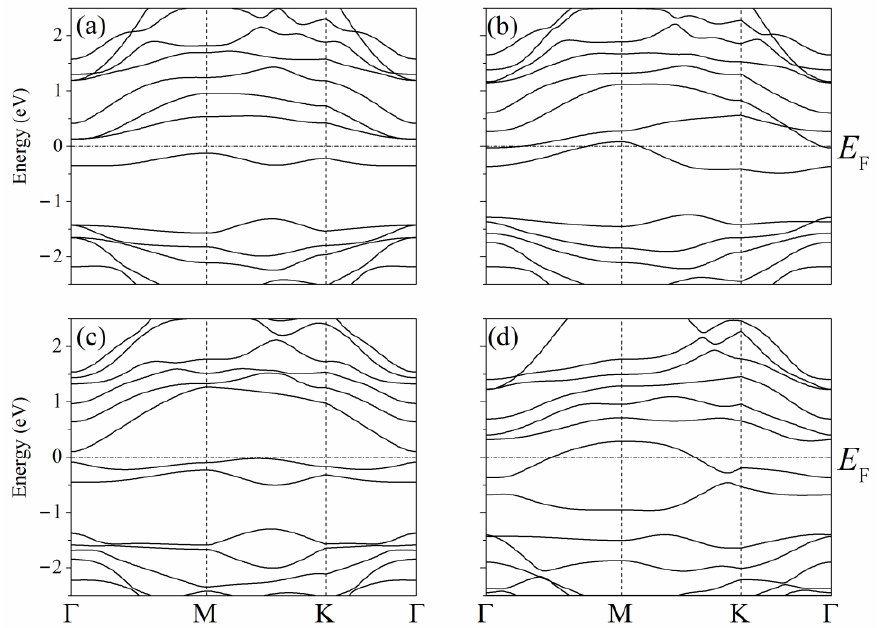
Figure 7. Band structures of silicene modified with one ( a , b ) or two ( c , d ) phosphorus atoms upon adsorption of one lithium atom in a position above the center of the six-membered ring; ( a ) and ( b )—P atom is in the lower or the upper sublattice of silicene, respectively, ( c )—two P atoms are in the lower sublattice or two P atoms are in the upper sublattice, ( d )—one P atom is in the upper sublattice, and the other P atom is in the bottom one. Reprinted with permission from Ref. [45]. 2021, Elsevier.